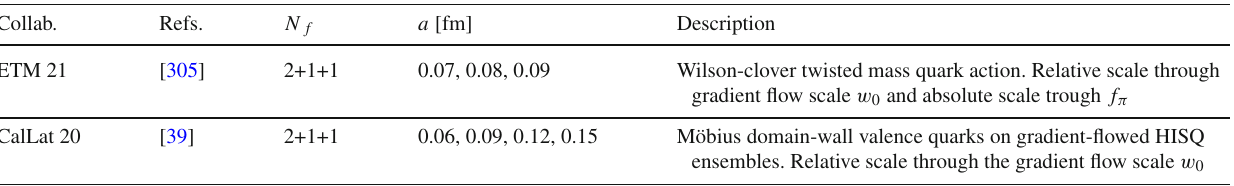
Table 106 Continuum extrapolations/estimation of lattice artifacts in determinations of f K / f π for N f = 2 + 1 + 1 simulations Collab.